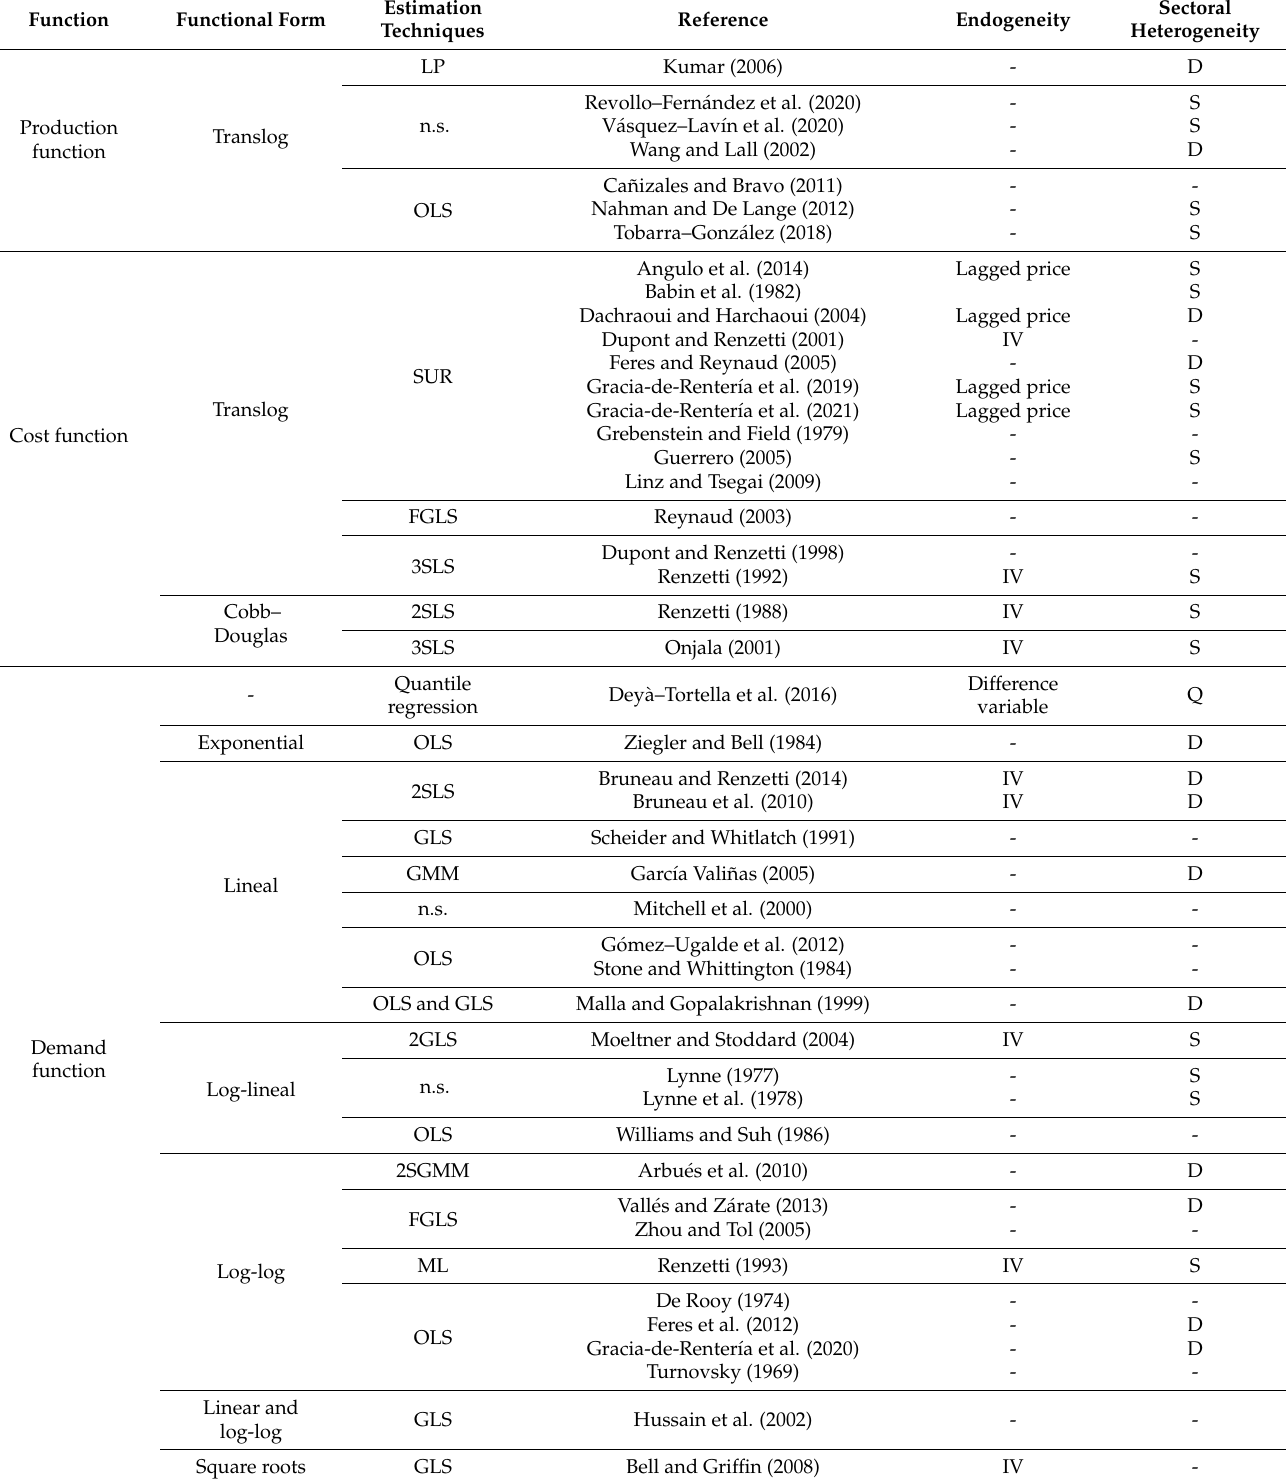
Table 3. Estimated function and